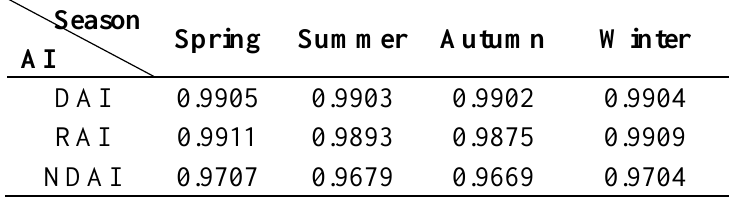
Table 3. Correlation coefficient between aerosol indices (AI) and AOD in four